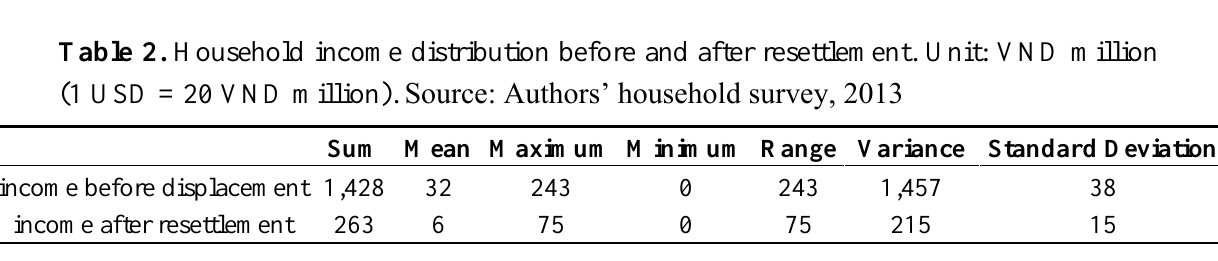
Figure 5. Accessible income sources of households before and after resettlement ( n =